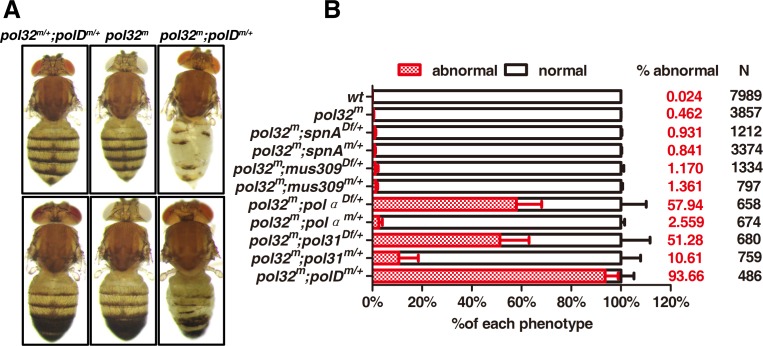
Genetic interactions between pol32 and other DNA replication and repair factors.A. Pictures of adult flies (three females at the top and three males at the bottom) showing etching of the abdominal region. Genotypes are given at the top. B. Quantification of the “etched abdomen” phenotype. The specific mutant alleles (m) are as followed: pol32m
= pol32L27/L30, spnAm
= spnA1, spnADf
= Df(3R)X3F, mus309m = mus309D2, mus309Df = Df(3R)P-21, polαm
= polαG13925, poldm
= poldl10, polαDf = Df(3R)Exel6186, pol31m
= pol31G16501, pol31Df = Df(3L)Bsc122.